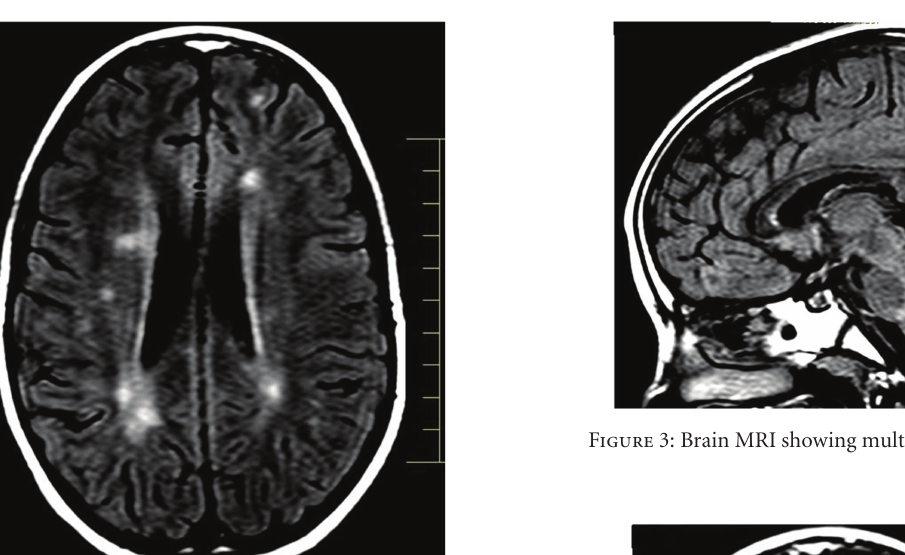
visual fields and routine ophthalmoscopy. Blood laboratory